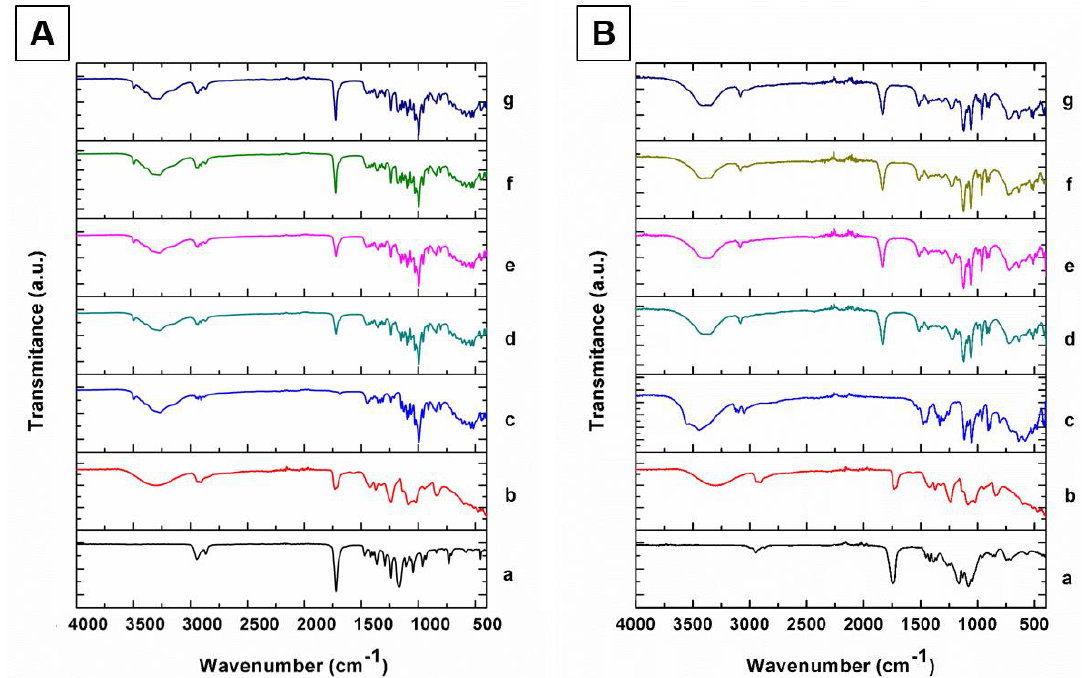
Figure 2. ( A ) Spectra of the PCL / PVA NP system; (a) PCL, (b) PVA, (c) trehalose, (d) non-sterilized PCL / PVA NP, (e) PCL / PVA NP after UV radiation, (f) PCL / PVA NP after 5 kGy of gamma radiation, and (g) PCL / PVA NP after 10 kGy of gamma radiation. ( B ) Spectra of the PLGA / PVA NP system; (a) PLGA, (b) PVA, (c) mannitol, (d) non-sterilized PLGA / PVA NP, (e) PLGA / PVA NP after UV radiation, (f) PLGA / PVA NP after 5 kGy of gamma radiation, and e) PLGA / PVA NP after 10 kGy of gamma radiation.